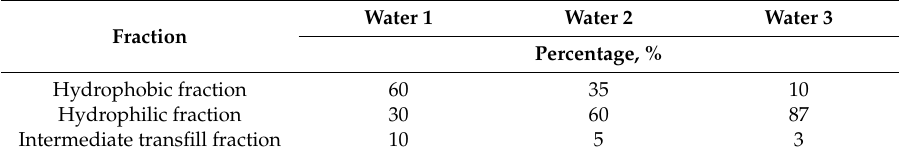
Table 1. Share of the Natural Organic Matter (NOM) fractions on groundwaters.